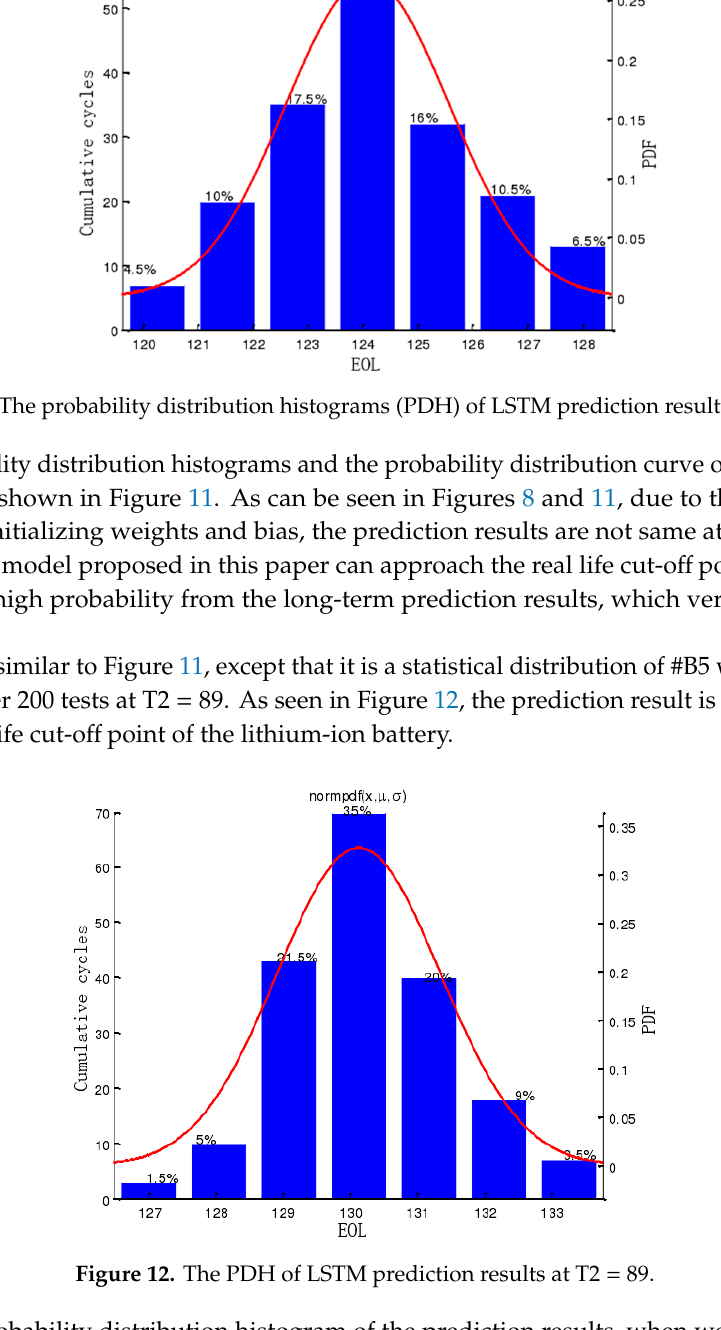
Energies 2019 , 12 , x 10 of 14 Figure 10. The predictions result of LSTM at T3 = 109. The prediction result of LSTM at T3 = 109 is shown in Figure 10. As can be seen in the Figure 10,